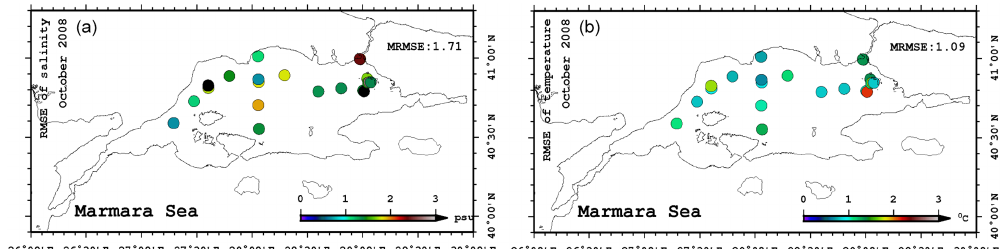
Figure 8. Spatial distribution of RMS of (a) salinity and (b) temperature error computed at the top 50m of each CTD cast in October 2008.